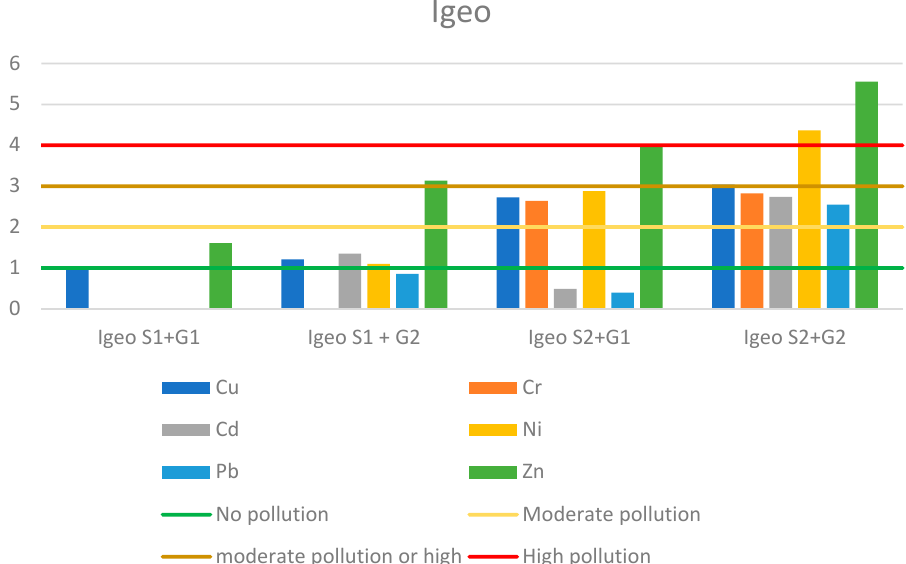
Figure 9. Value of geoaccumulation index (Igeo) in sludge–soil mixtures. (S1 Sitkowka, S2 Kunow, G1 Opatowiec, G2 Jastrzab).